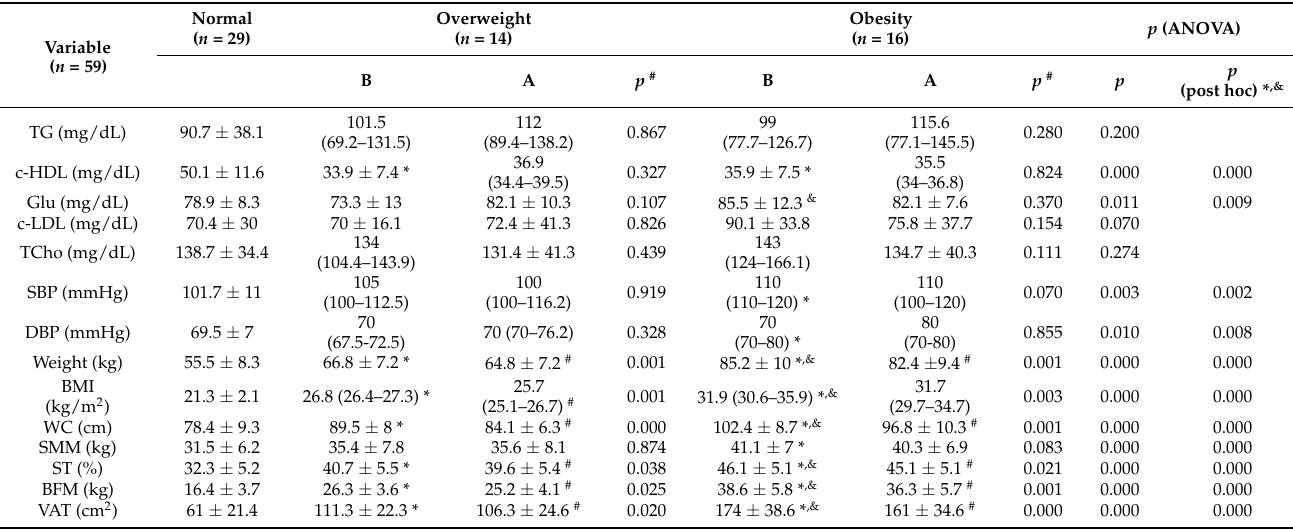
Table 2. Biochemical indicators, anthropometric measurements and body composition according to BMI, before and after 2 months of the dietary plan.